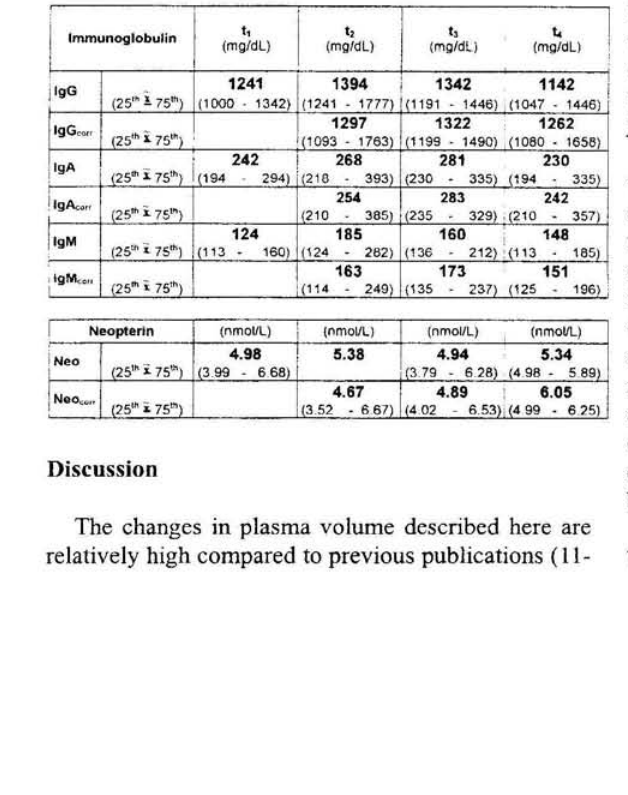
Table 4: Plasma values of immunoglobulins and neopterin, uncorrected and corrected for PV-changes (corr) before (tl), immediately after the marathon (t2), 3h after (t3) as well as 34h after (t4) the marathon. Data are given as median values and the 25 lb and 75 th percentiles in brackets,